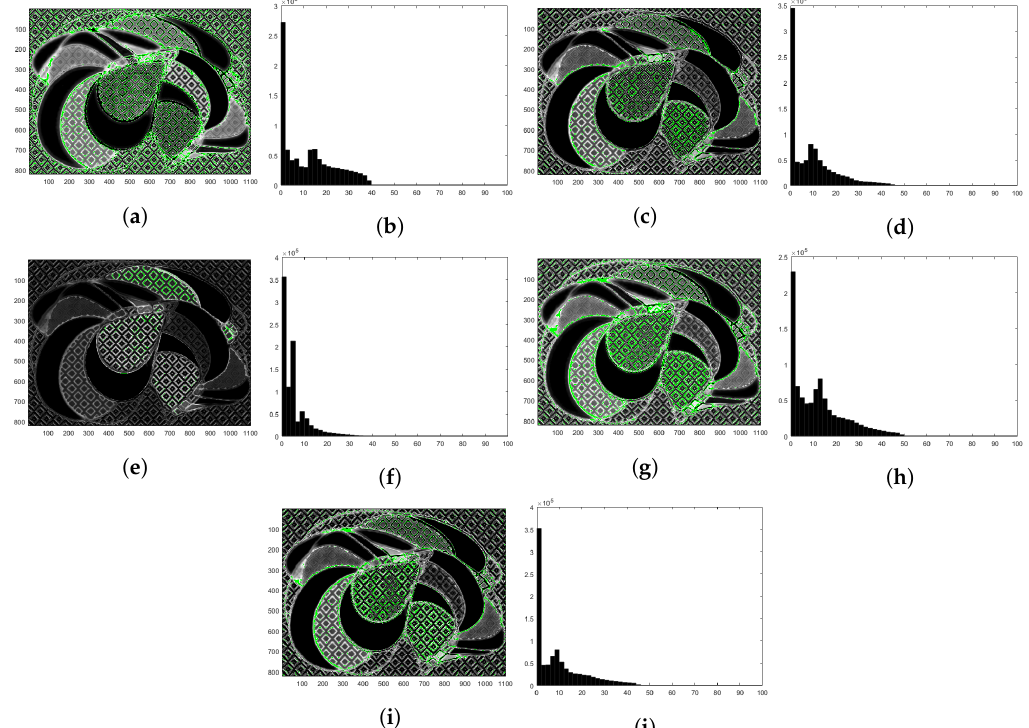
Figure 12. S-CIELAB Spatial distribution of errors and error histogram: ( a ) Spatial distribution of errors between Figure 11a and the sparse coding results in Figure 11c that are 30 units or higher, marked in green; ( b ) S-CIELAB histogram distribution between Figure 11a and the sparse coding results in Figure 11c; ( c ) Spatial distribution of errors between Figure 11a and the single image CSC results in Figure 11d that are 30 units or higher, marked in green; ( d ) S-CIELAB histogram distribution between Figure 11a and the single image CSC results in Figure 11d; ( e ) Spatial distribution of errors between Figure 11a and the single image SVD-CSC results in Figure 11e that are 30 units or higher, marked in green; ( f ) S-CIELAB histogram distribution between Figure 11a and the single image SVD-CSC results in Figure 11e; ( g ) Spatial distribution of errors between Figure 11a and the large data CSC results in Figure 11f that are 30 units or higher, marked in green; ( h ) S-CIELAB histogram distribution between Figure 11a and the large data CSC results in Figure 11f; ( i ) Spatial distribution of errors between Figure 11a and the large data SVD-CSC results in Figure 11g that are 30 units or higher, marked in green; ( j ) S-CIELAB histogram distribution between Figure 11a and the large data SVD-CSC results in Figure